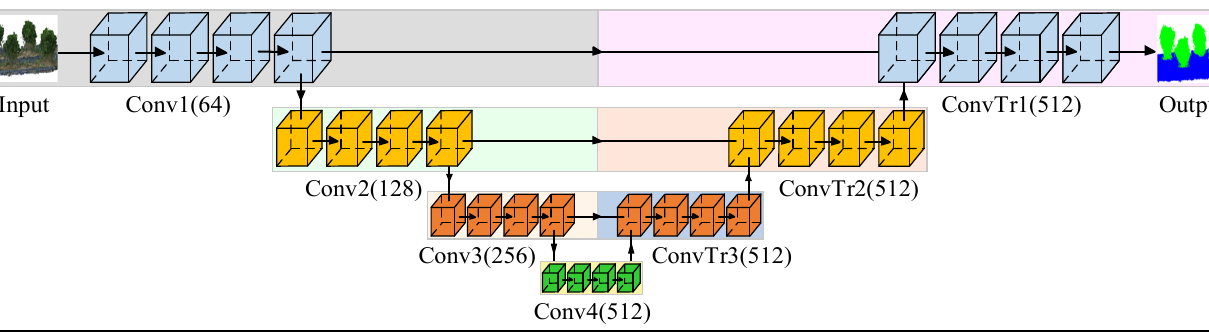
Figure 6. Overall network architecture of MinkowskiNet.